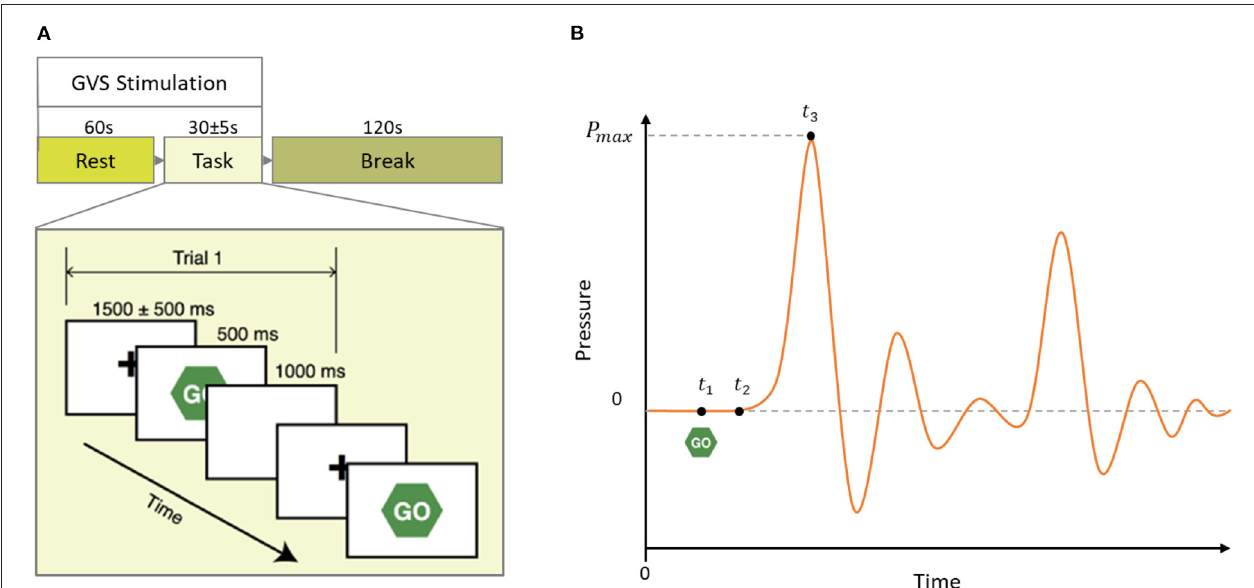
FIGURE 2 | (A) Schematic of a block of the experimental paradigm in which 60s rest followed by 10 task trials and 120s break time. In each block, GVS stimulation (Sham, GVS1: 50–100Hz, and GVS2: 100–150Hz) was delivered during the rest and task period. (B) Mock pressure signal of a squeezing bulb. GO screen appeared at t 1 , the participant started to squeeze the bulb at t 2 and reached maximum pressure at t 3 . Peak time is defined as t 3 − t 1